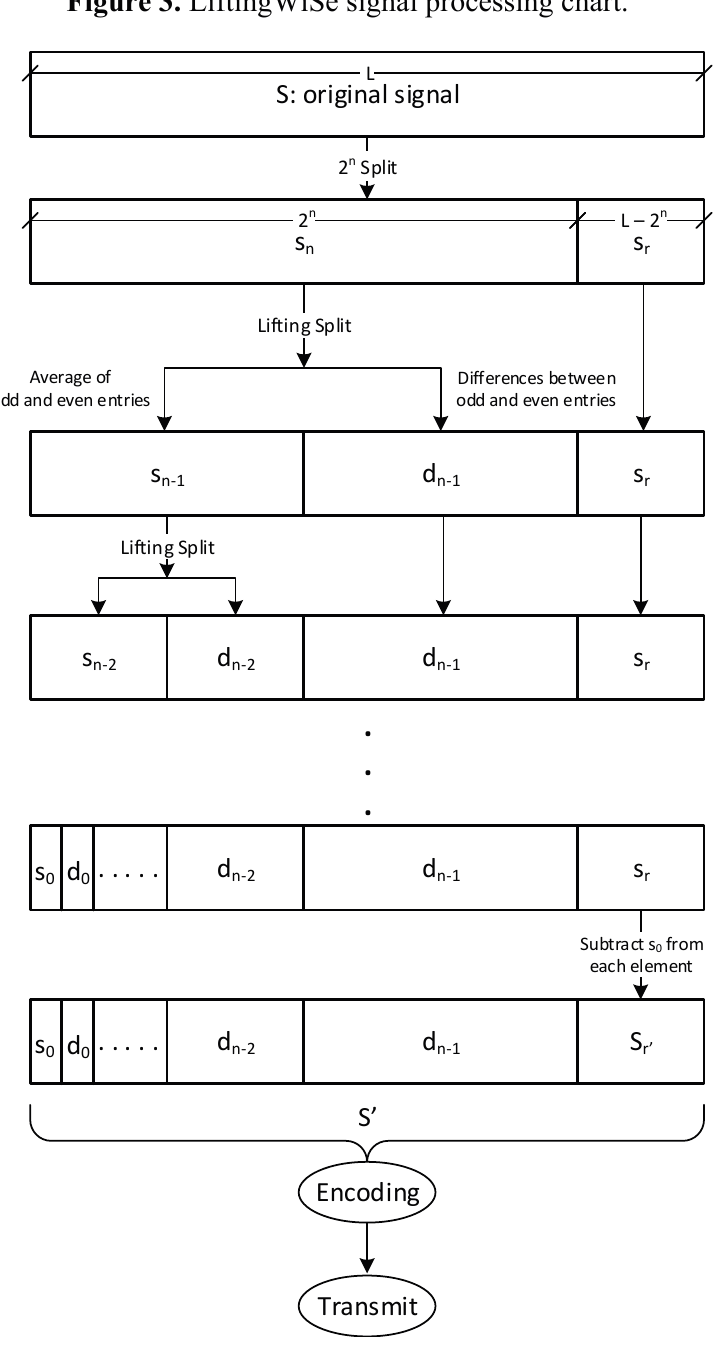
Figure 3. LiftingWiSe signal processing